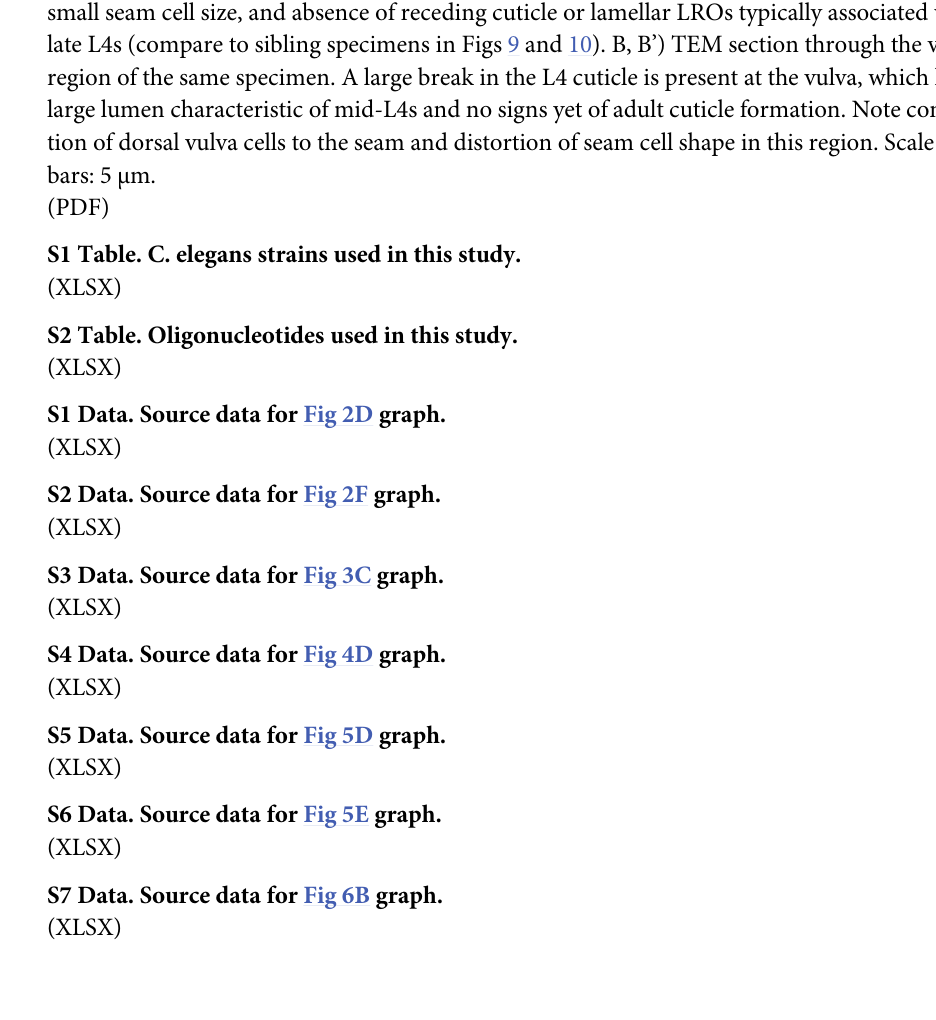
S1 Table. C. elegans strains used in this study. S2 Table. Oligonucleotides used in this study. S1 Data. Source data for Fig 2D graph. S2 Data. Source data for Fig 2F graph. S3 Data. Source data for Fig 3C graph. (XLSX) S4 Data. Source data for Fig 4D graph. (XLSX) S5 Data. Source data for Fig 5D graph. (XLSX) S6 Data. Source data for Fig 5E graph. S7 Data. Source data for Fig 6B